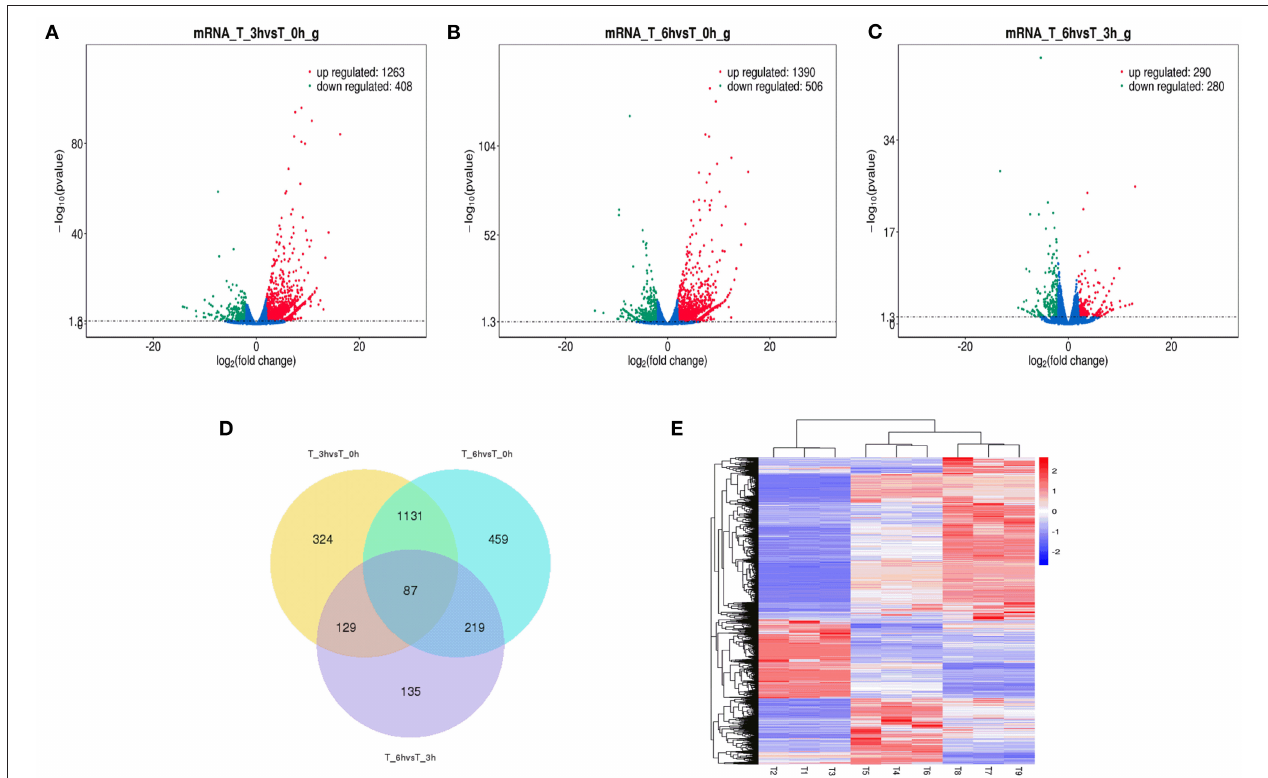
FIGURE 5 | Changes in circRNAs expression during SE infection in duck granulosa cells. (A–C) Volcano plots showing up- and down-regulated circRNAs of 3 vs. 0, 6 vs. 0, and 6 vs. 3 hpi group, respectively. (D) Venn diagram showing the number of overlapping differentially expressed circRNAs between 0, 3, and 6 hpi. (E) Heat map of circRNAs showing hierarchical clustering of DE-mRNAs between 0, 3, and 6 hpi. Up- and down-regulated circRNAs are shown in red and blue, respectively.